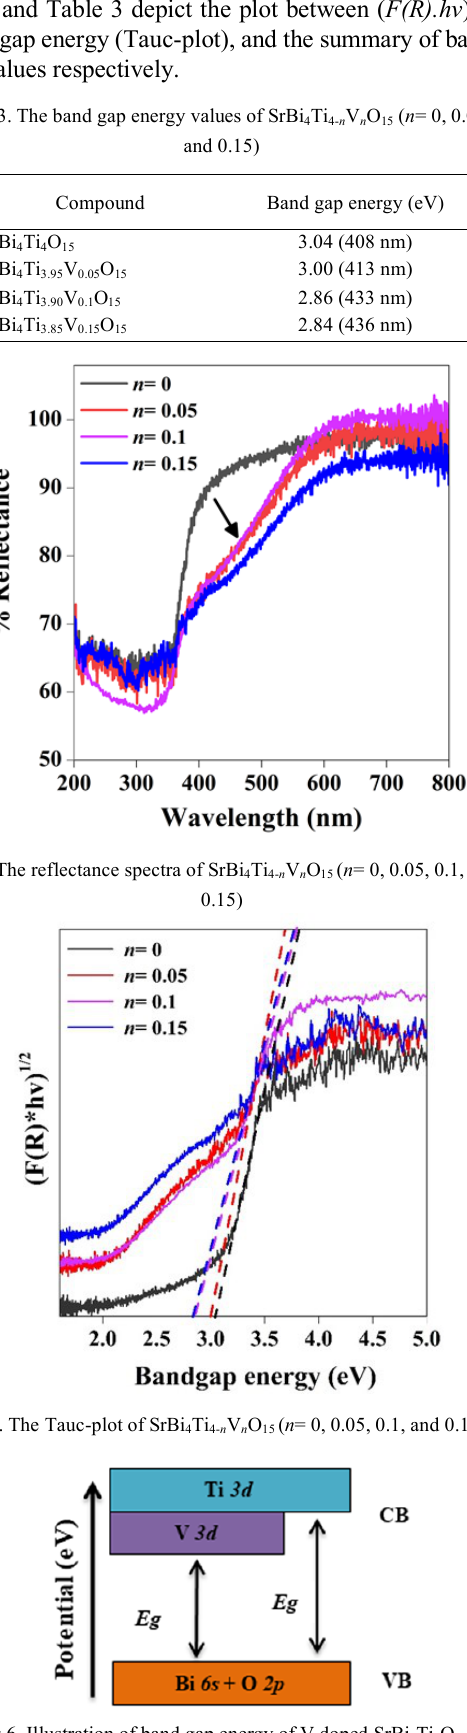
Fig 6. Illustration of band gap energy of V doped SrBi 4 Ti 4 O